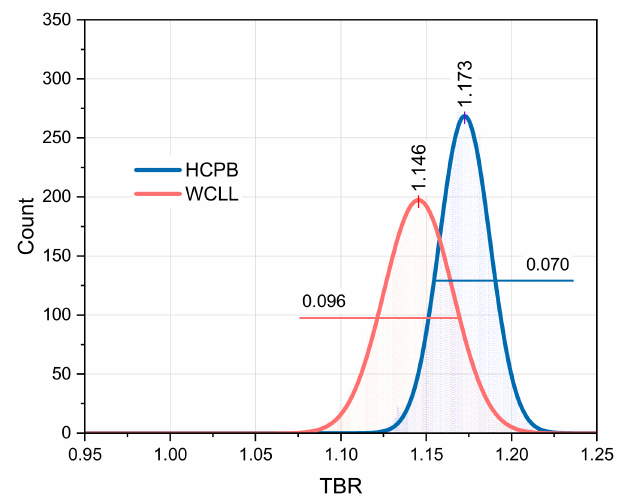
Figure 11. The TBR distribution for the TENDL-2017 data with random files for each nuclide and 300 random files for n+ 56 Fe from